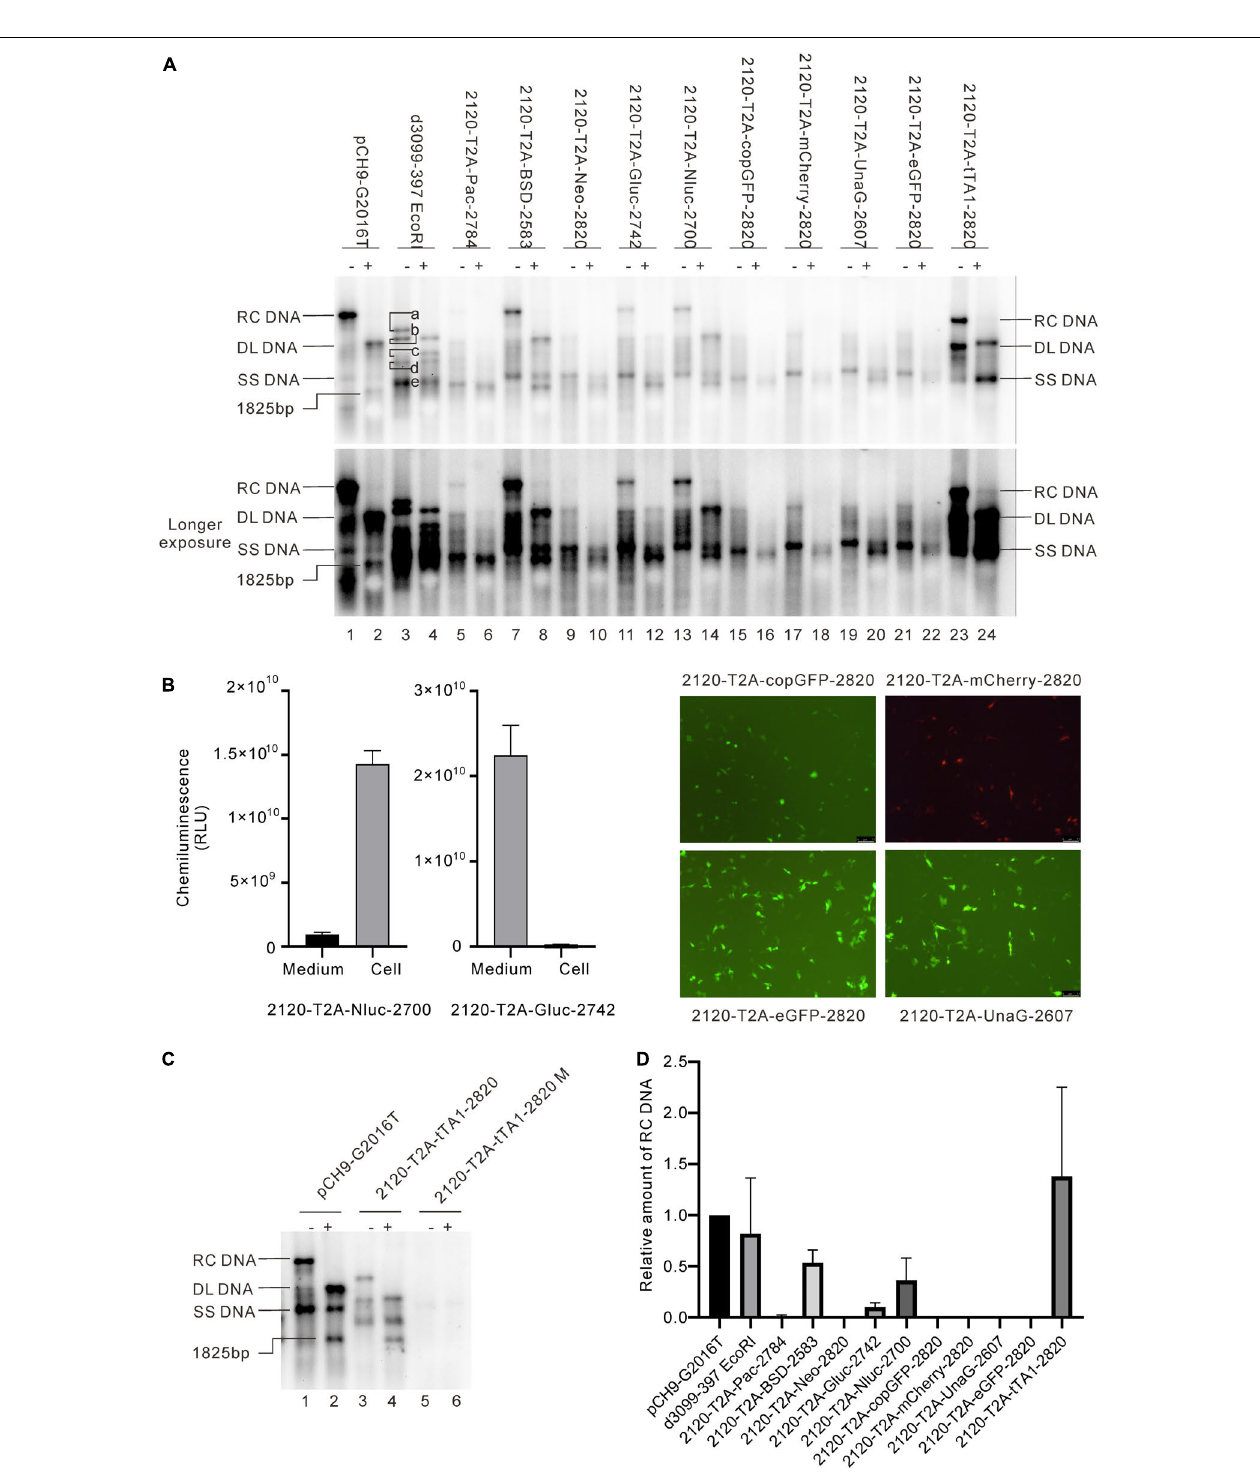
FIGURE 3 | Influence of the recombination at 2120 on HBV DNA replication. (A) Representative Southern blotting results of the recombinants. The plus sign (+) denotes Eco RI digestion. RC, DL, SS DNA, and Eco RI digested fragments are shown. (B) Expression of the exogenous genes from the recombinants. Luciferase activity (Gluc and Nluc) or fluorescence (copGFP, eGFP, mCherry, and UnaG) was detected. (C) Representative Southern blotting of 2120-T2A-tTA1-2820 M. Notably, M denotes a deletion from nt 2064 to 2072 and a mutation in tetR (A426G). (D) The relative intensity of RC DNA of the recombinants. The intensity of each RC DNA was divided into the sum of RC DNA of all samples in the same membrane, respectively, to calculate the relative intensity of RC DNA of each sample. N = 4.